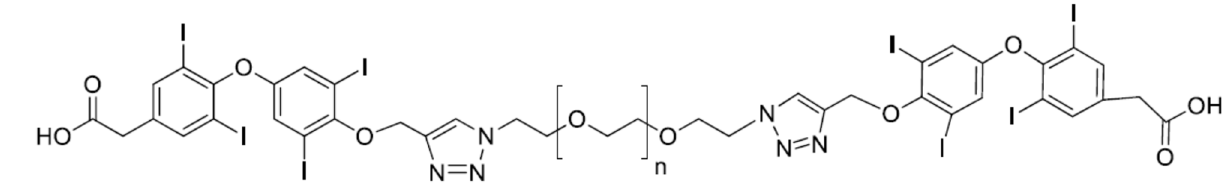
Figure 8. Molecular structure of the P-bi-TAT as reported in our previously published study [7]. Adopted from our previously published contribution [7]. Copyright © 2019 American Chemical Society.